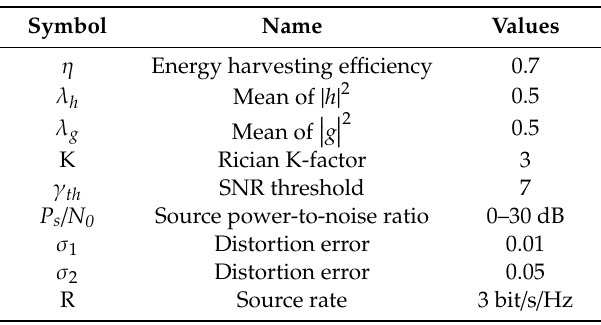
Table 1. The main simulation